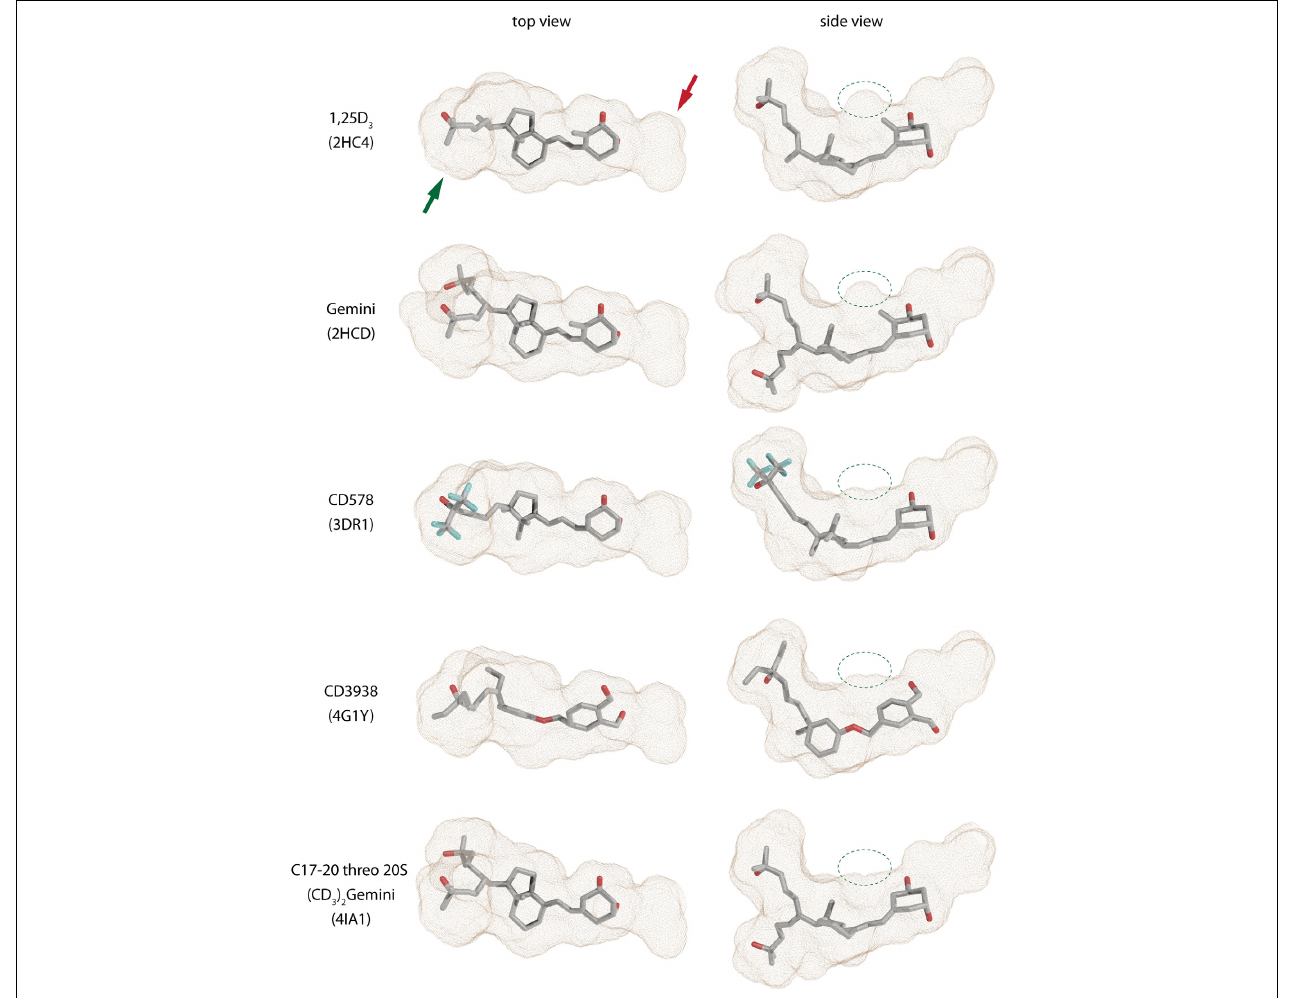
FIGURE 3 | Shapes of the zebrafish VDR ligand-binding pockets (LBPs) with various compounds (source PDBID: 2HC4, 2HCD, 3DR1, 4G1Y, and 4IA1).